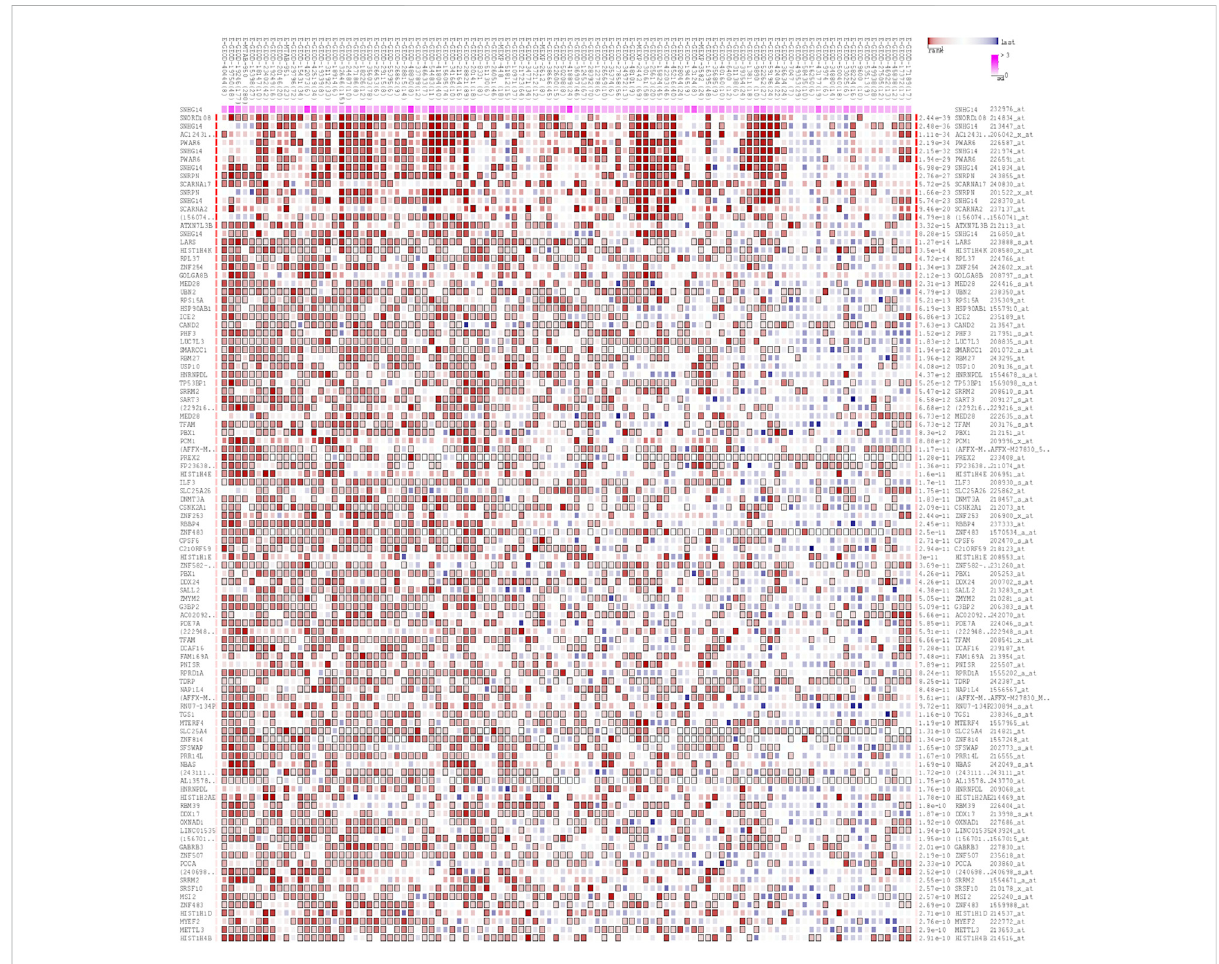
FIGURE 7 The top 150 predicted target genes of SNHG14 by using Multi Experiment Matrix (MEM, http://biit.cs.ut.ee/mem/)